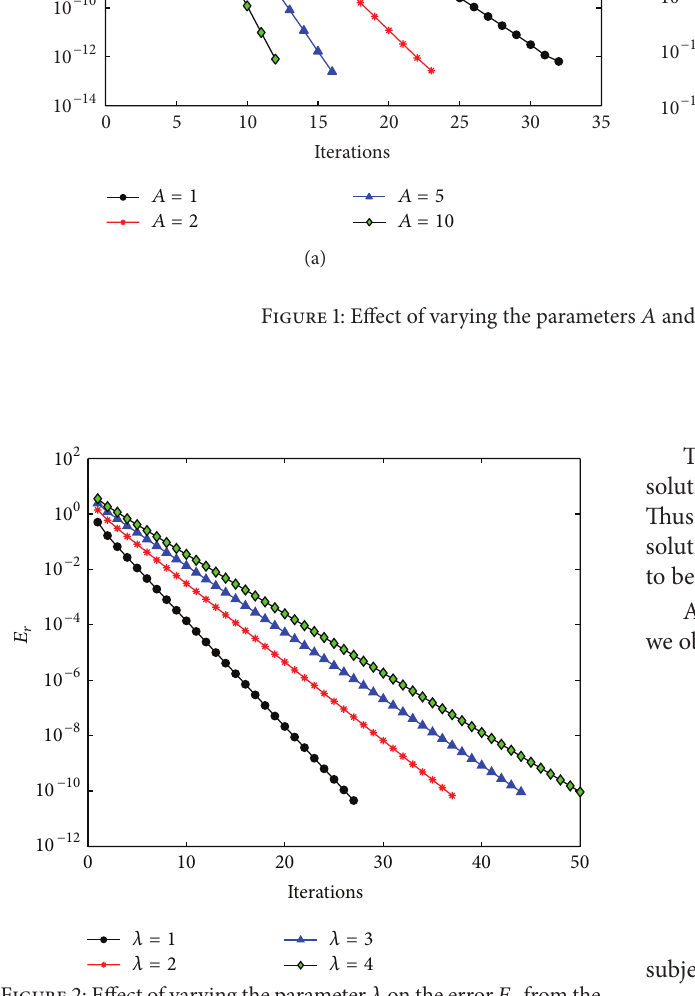
Figure 2: Effect of varying the parameter 𝜆 on the error 𝐸 𝑟 from the SRM